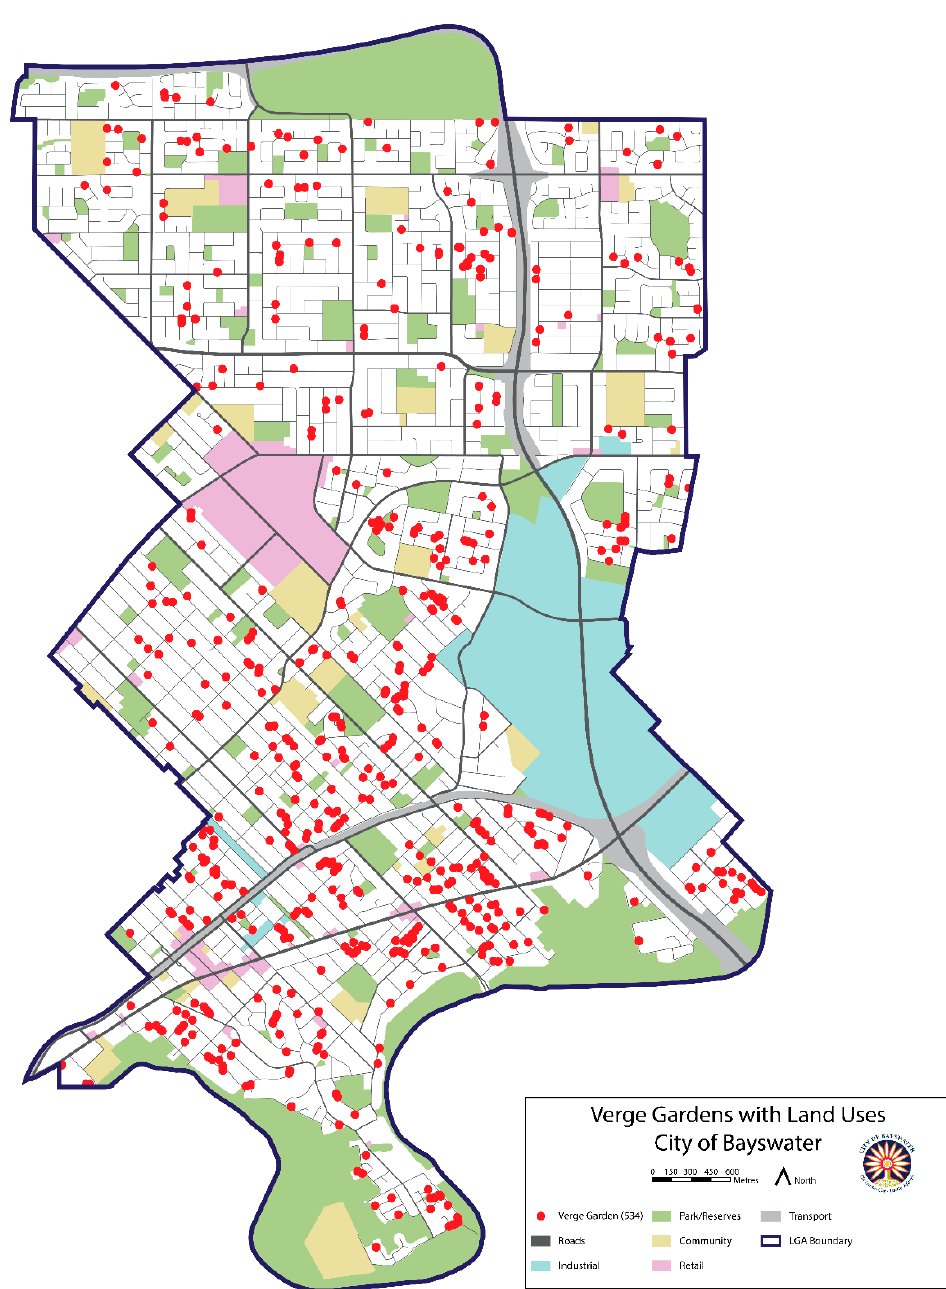
Figure 4. Location of verge gardens in the City of Bayswater.